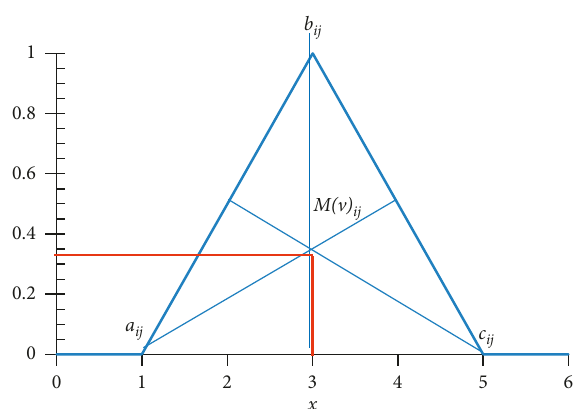
Figure 2: The generalized mean for